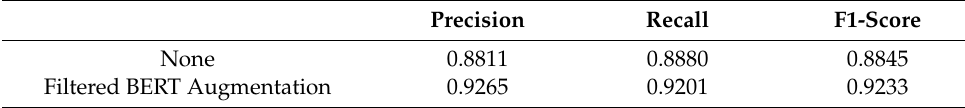
Table 3. Named entity recognition performance evaluation